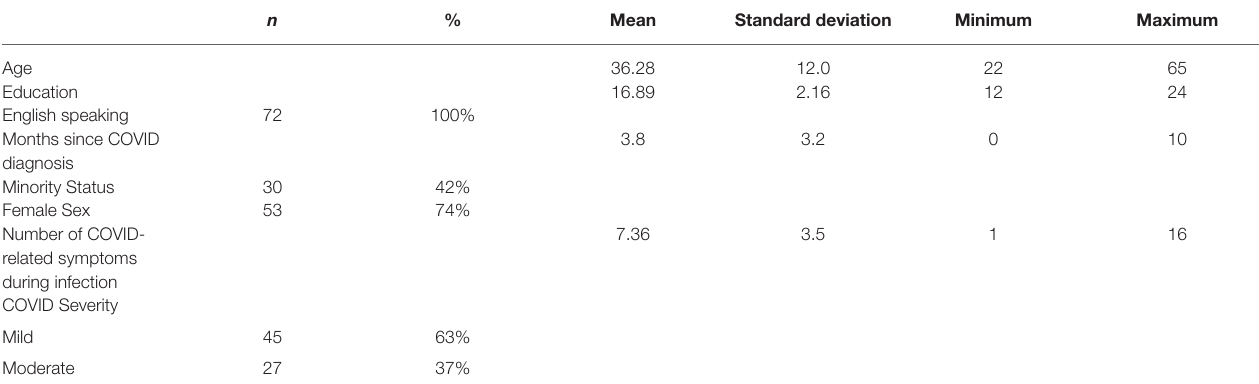
TABLE 1 | Demographic and clinical characteristics.